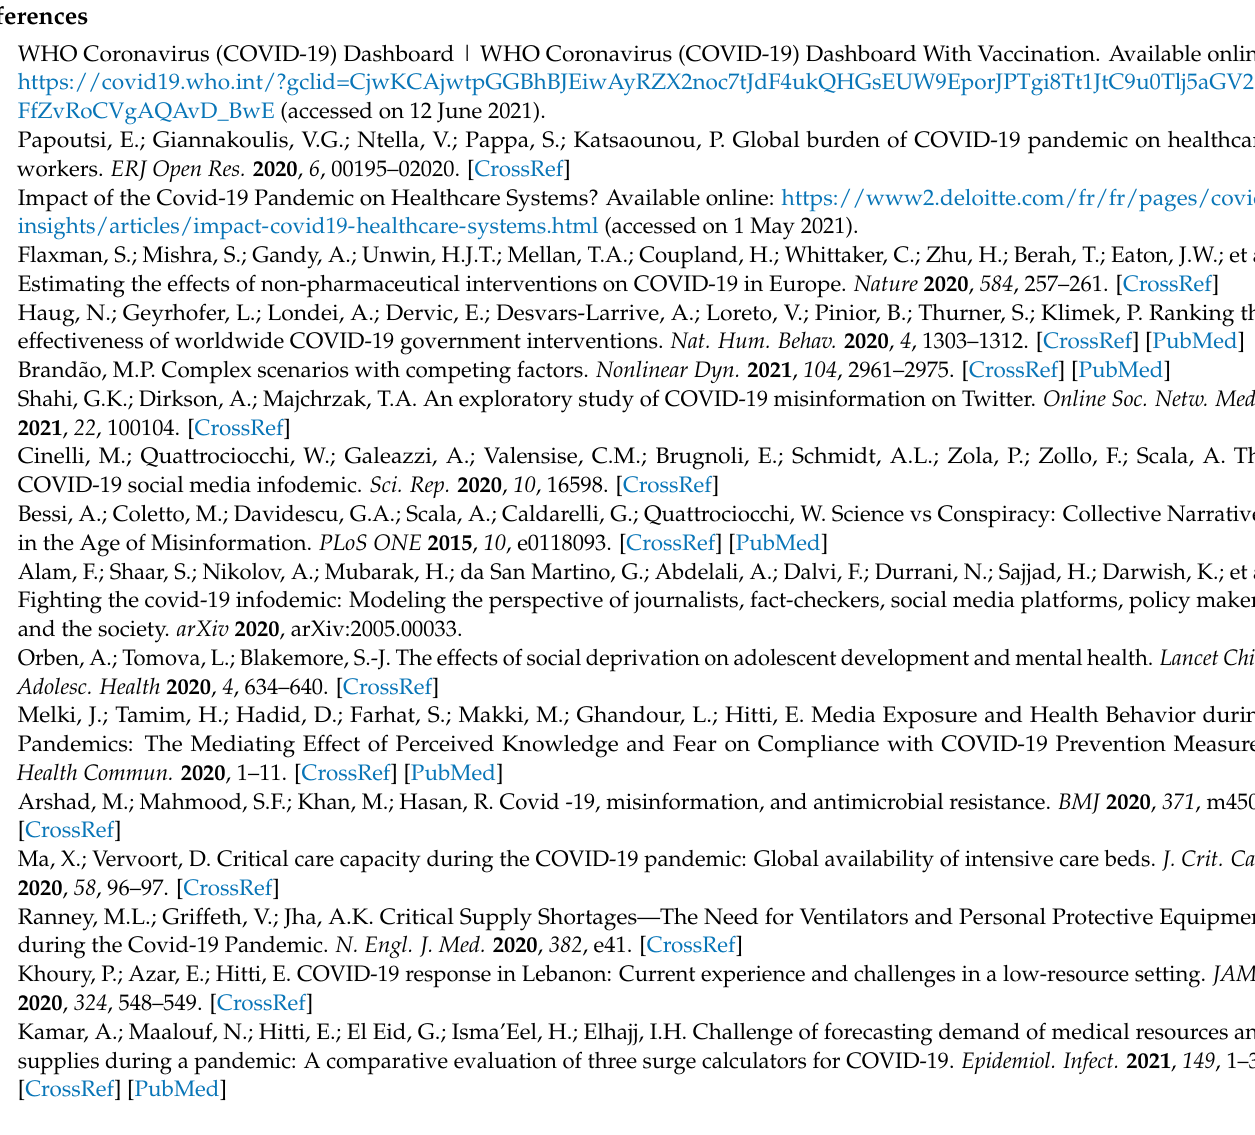
Table S1b: Total isolates/1000PD, all sample